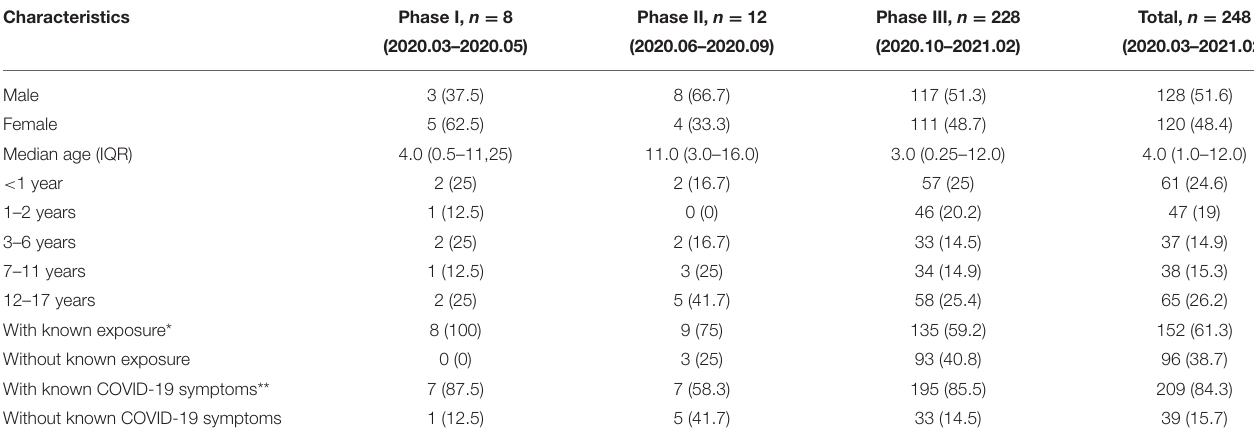
TABLE 1 | Comparison of SARS-CoV-2 positive subjects in Phases I–III.